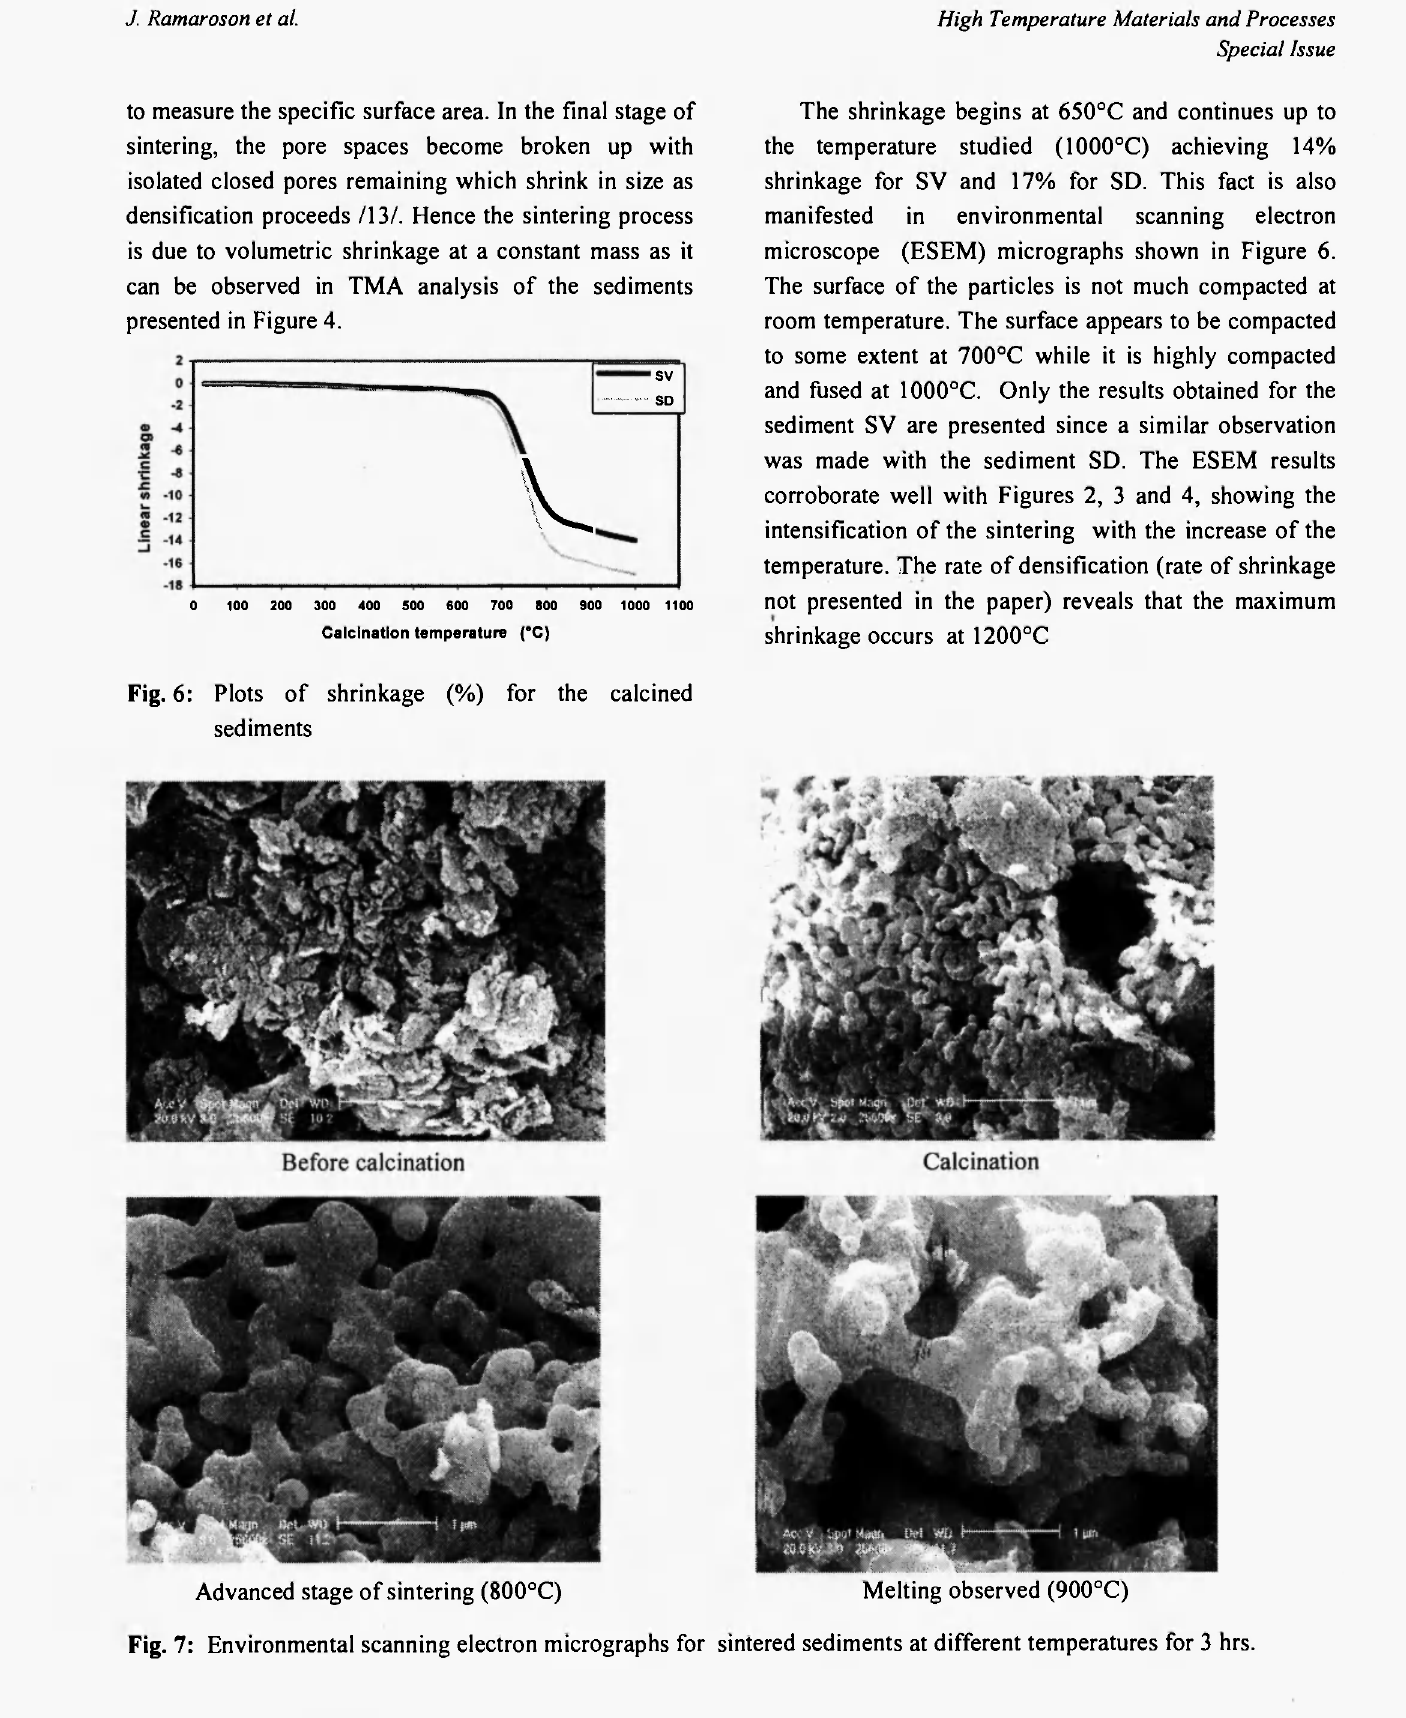
Fig. 7: Environmental scanning electron micrographs